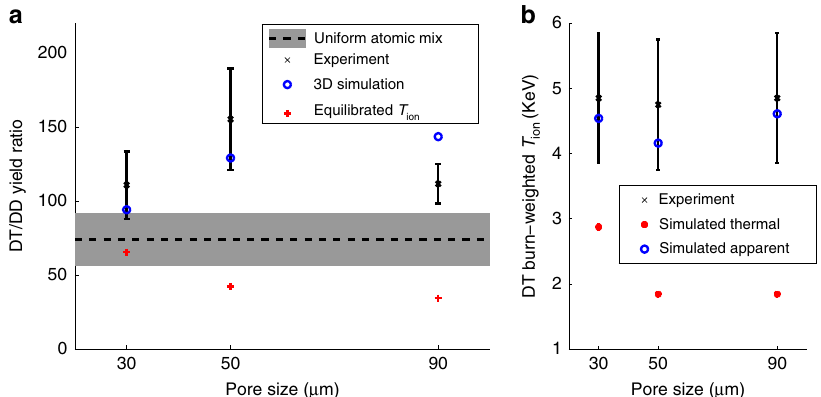
Fig. 3 Comparison between 3D simulations and experiments. a DT ∕ DD reaction yield ratios corrected for as-shot variations. The black ‘ x' symbols denote the experimental values with the solid black lines indicating the experimental measurement error, determined based on the method described in ref. 62 . The black dashed line indicates the maximum theoretical yield ratio (Eq. (3)) for uniform atomic mix and the shaded region indicates uncertainty. This uncertainty is the maximum and minimum possible values calculated based on measurement uncertainties of foam densities, foam composition, fi ll pressure, and fi ll gas composition. Measurement errors are quanti fi ed in the Methods section and described in 42 – 44,63 – 65 . The red plus symbols indicate values that would have resulted from simulations if the reactants were in thermal equilibrium. b Comparison of experimental burn-weighted T i , simulated thermal burn-weighted T i from 3D simulations, and simulated apparent (including fl uid motion corrections based on ref. 66 ) burn-weighted T i from 3D simulations. A forward- fi t approach using a relativistic energy distribution is used to analyzed the neutron time-of- fl ight signal to infer the neutron-average ion temperature, and the error bars are determined from the statistical uncertainty in this fi t to the data 67